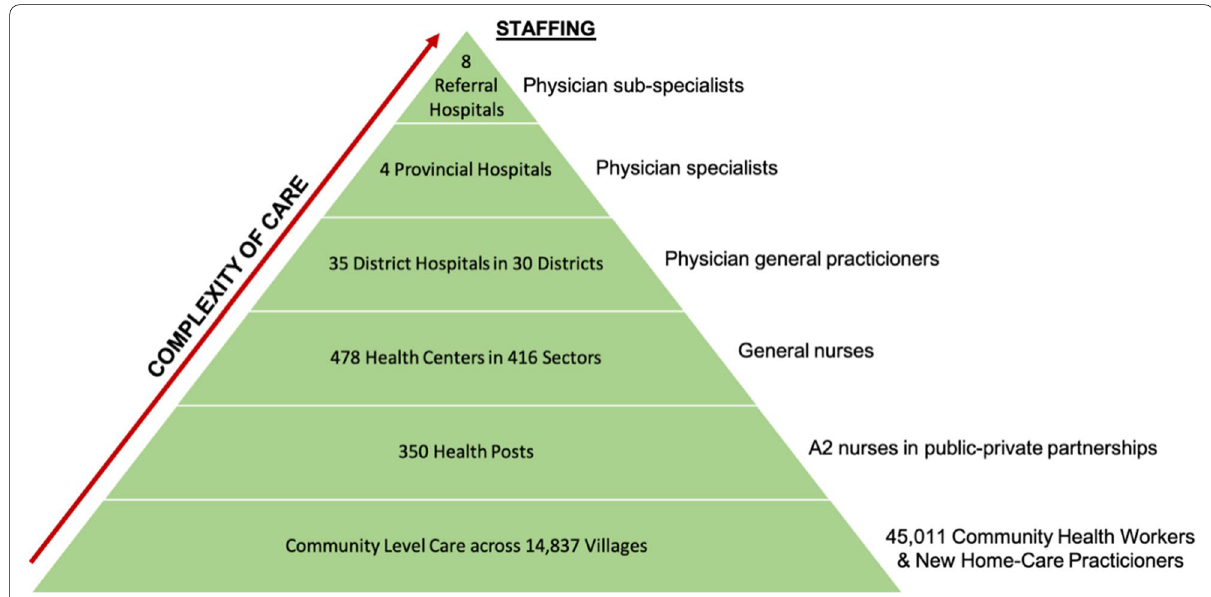
Fig. 1 Rwanda’s decentralized healthcare system (adapted from Binagwaho et al., 2015)